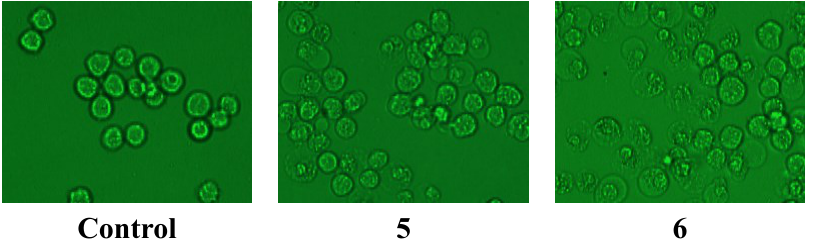
Figure 5. Photographs of K562 cells treated with 5 – 8 for 24 h at 100 µg/mL.